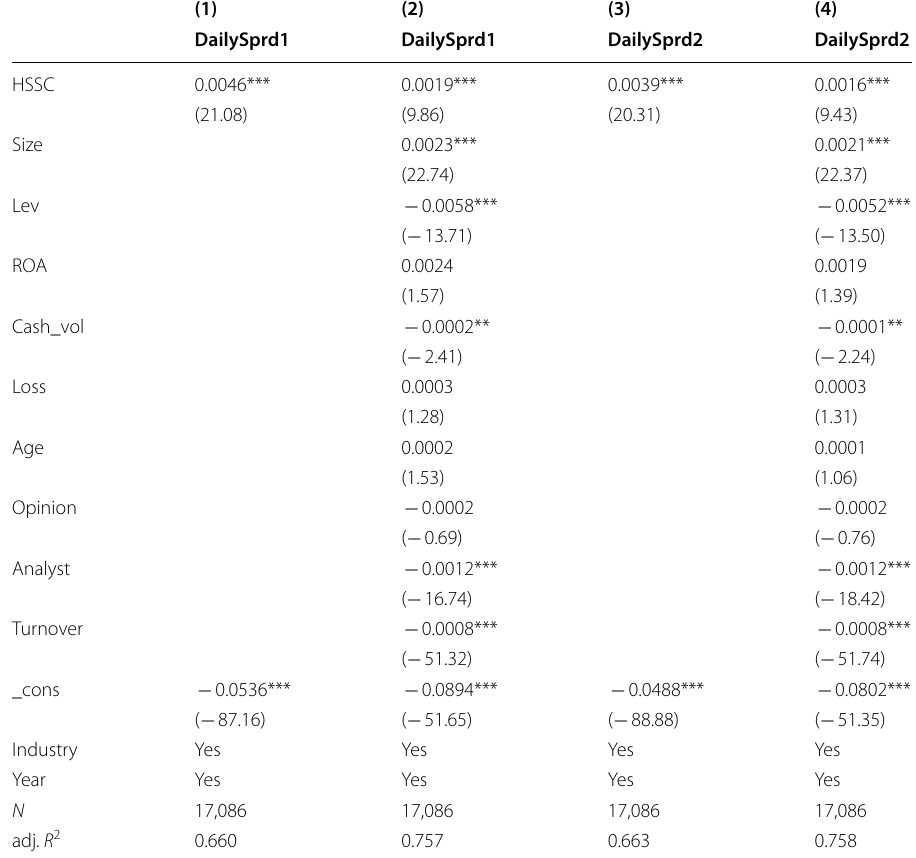
Table 2 Baseline regression results: the stock market liberalization and market